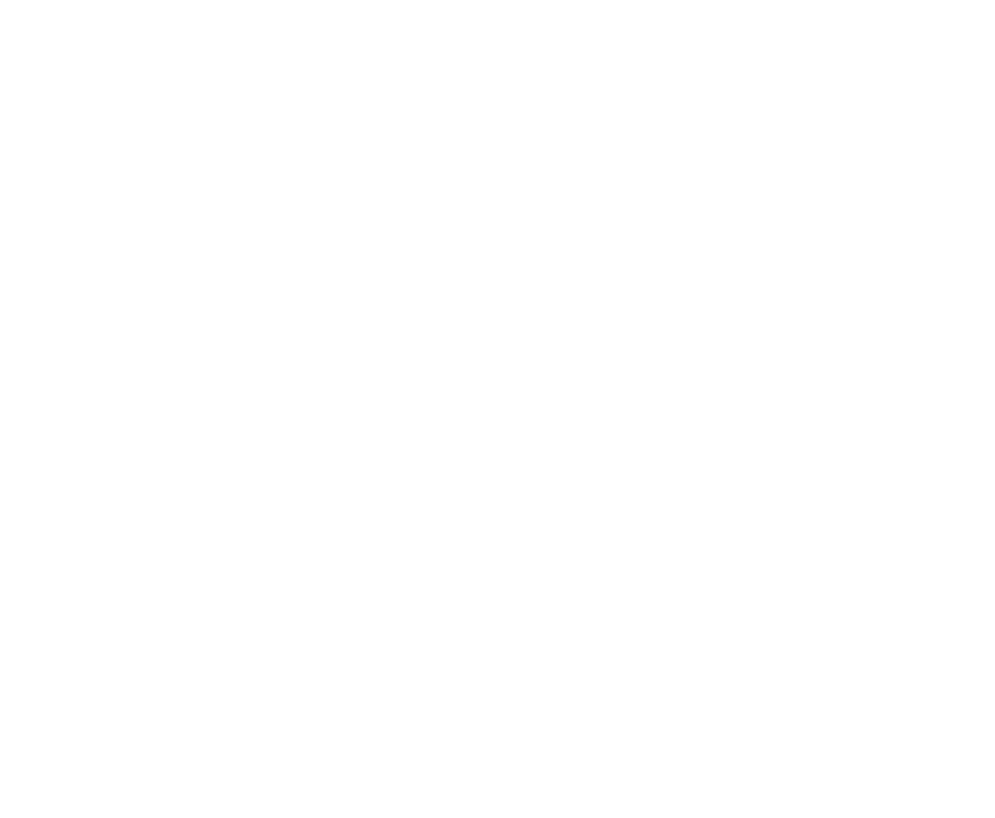
dinucleotides and black circles represent methylated CpG dinucleotides. Gray circles represent CpG sites that were converted to CpA or TpA, as occasionally can be observed. Each row is derived from an individual subclone. Percent of CpG methylation appears below the cell